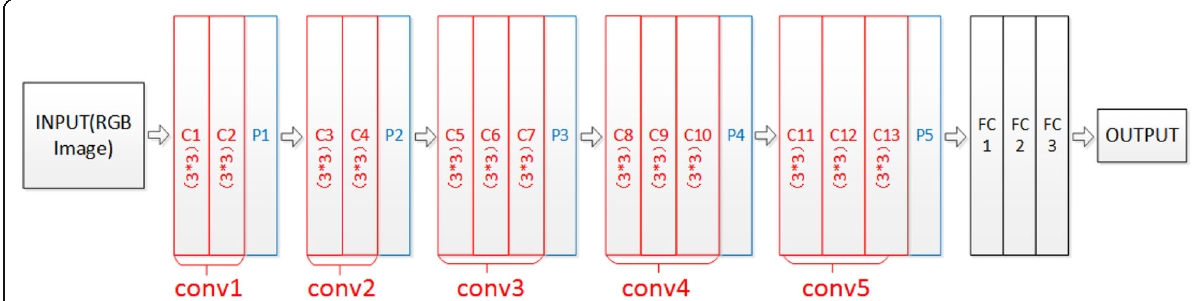
Fig. 1 Network structure of VGG16. Among them, C1 – C13 represents convolution layer, P1 – P5 represents pooling layer, and FC1 – FC3 represents full connection layer. C1 and C2 as a whole can be regarded as Conv1 of 5 × 5 convolution layer, C5; C6, and C7 as a whole as Conv3 of 7 × 7 convolution layer; and so on. There are some hidden layers in the network structure, which will not be discussed here. Please refer to [4] for all